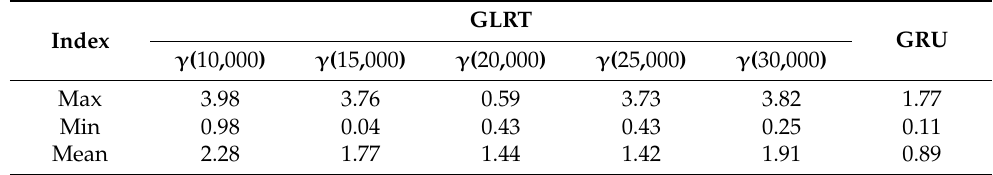
Table 2. Closed loop position error (m) obtained by different zero-velocity detection